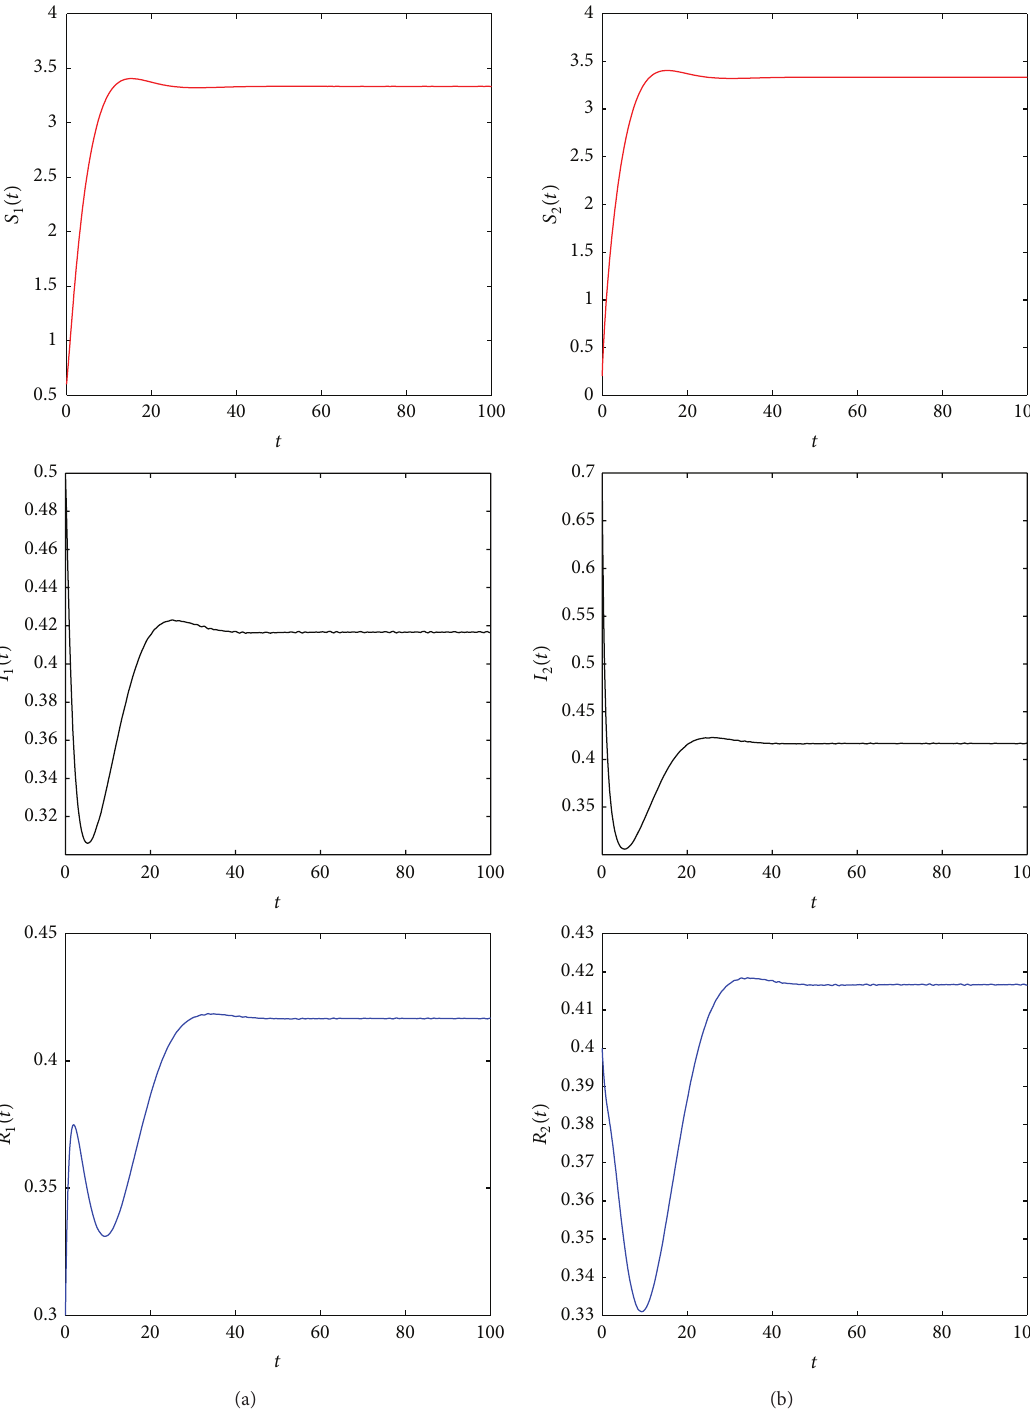
Figure 2: (a) shows movement paths of 𝑆 1 , 𝐼 1 , and 𝑅 1 as functions of time 𝑡 . (b) shows movement paths of 𝑆 2 , 𝐼 2 , and 𝑅 2 as functions of time 𝑡 . Here 𝑎 = 1 , 𝑏 = 0.2 , 𝑐 = 0.4 , 𝑑 = 0.2 , 𝛼 = 0.8 , 𝛽 = 0.6 , and 𝛾 = 0.5 . Initial data are 0.6, 0.5, 0.3, 0.2, 0.7, 0.4